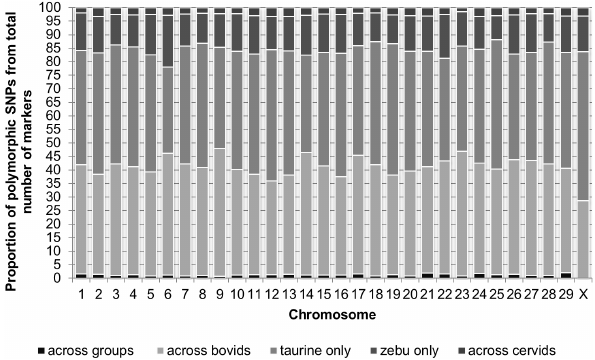
Figure 2. Proportion of SNPs by polymorphic status of the Bovi- neSNP50 BeadChip across bovids and